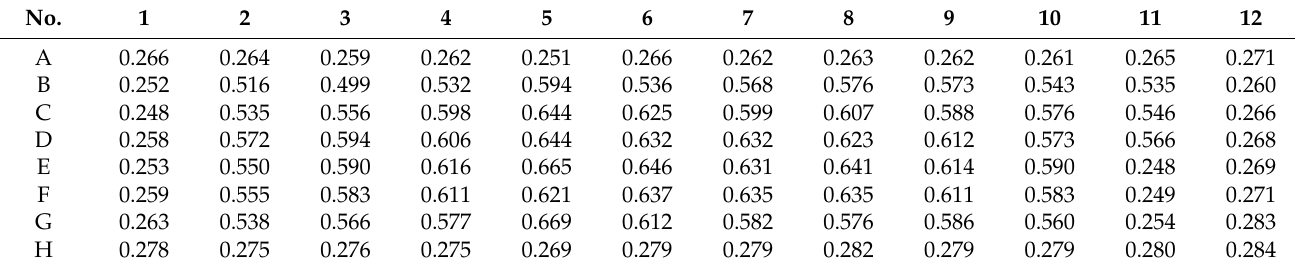
Table 8. Absorbance values of microplate wells in extract analysis.